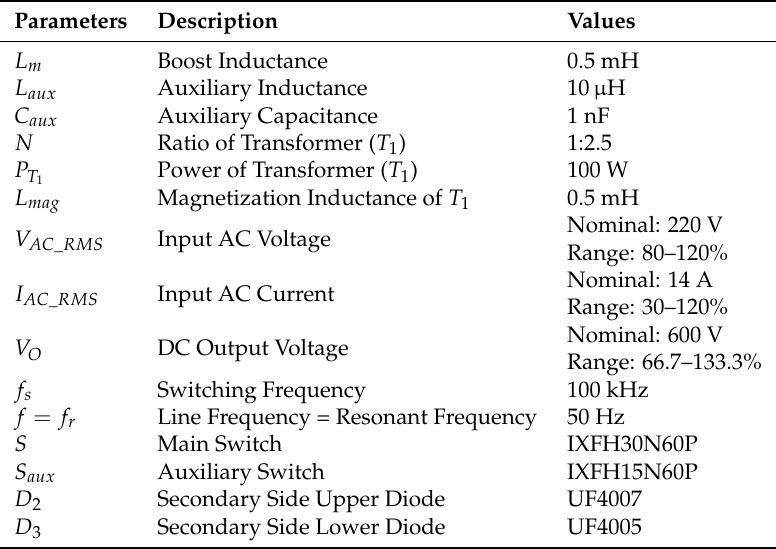
Table 1. Proposed converter components’